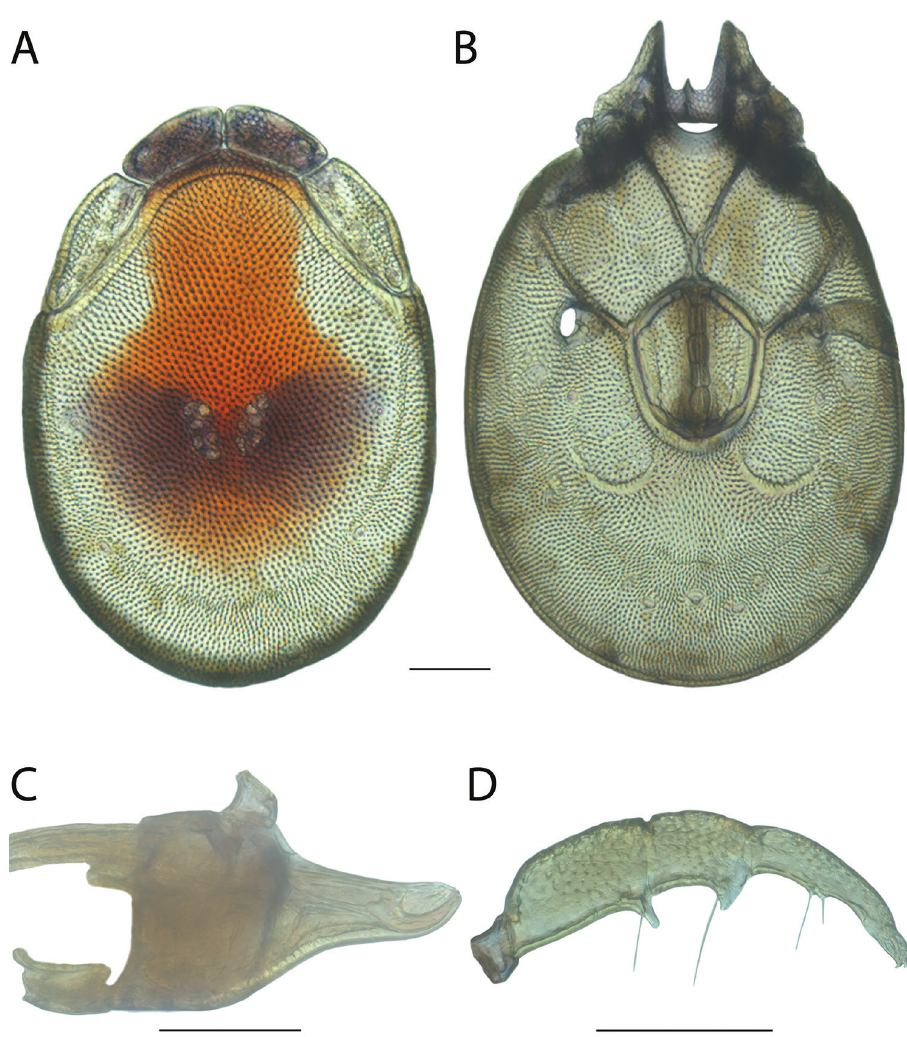
Figure 127. Torrenticola larvata female: A dorsal plates B venter (legs removed) C subcapitulum D pedipalp (setae not accurately depicted). Scale = 100